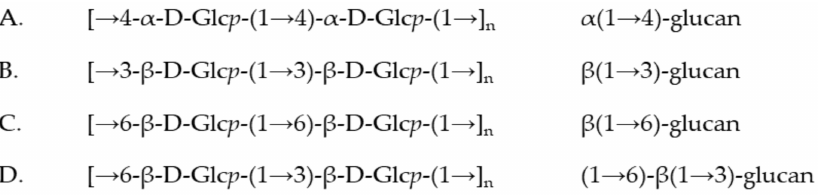
Figure 2. The structure of polysaccharides presented in fraction II ( A/B-C ) separated from Se-Le-30 crude extract: ( A ) α (1 → 4) glucan; ( B ) β (1 → 3) glucan; ( C ) β (1 → 6) glucan; ( D ) β (1 → 6)- β (1 → 3) glucan.